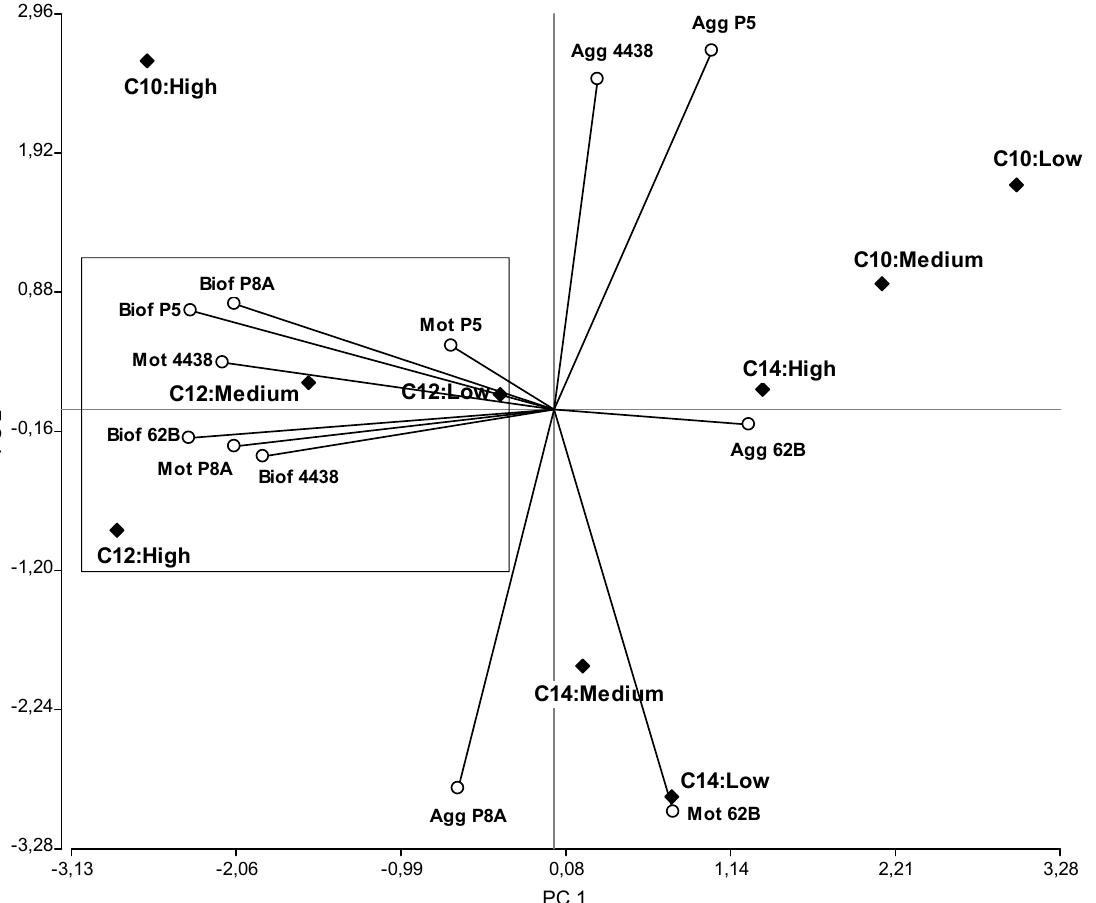
Figure 6. Overall effect of AHLs on various biological processes of peanut-nodulating strains.